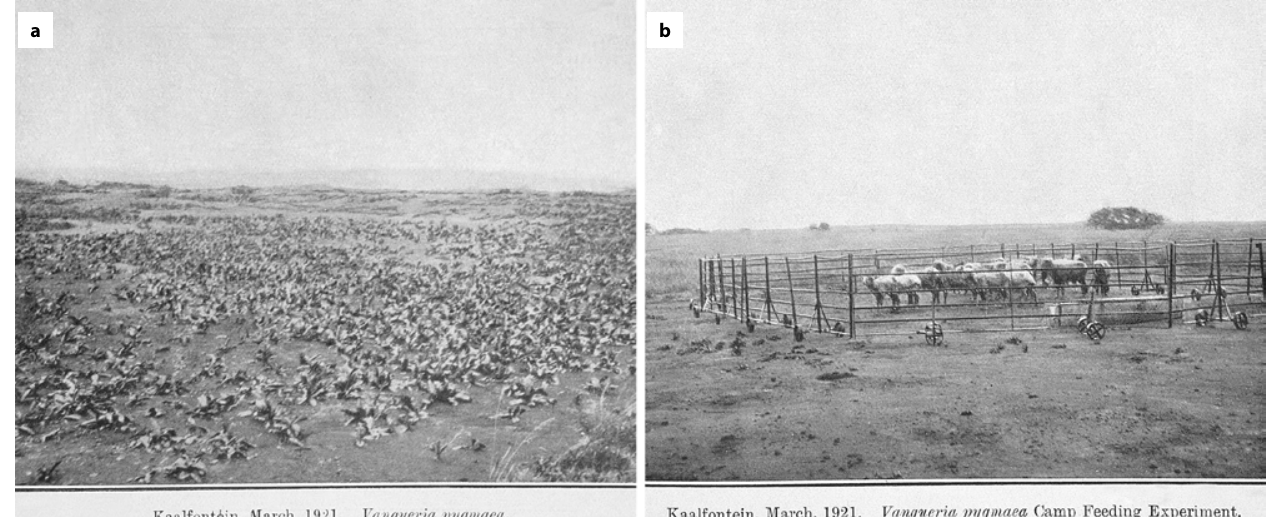
Figure 1a & b: Feeding experiment conducted by Theiler, Du Toit and Mitchell at Kaalfontein to investigate the cause of gousiekte (Theiler et al. 1923)